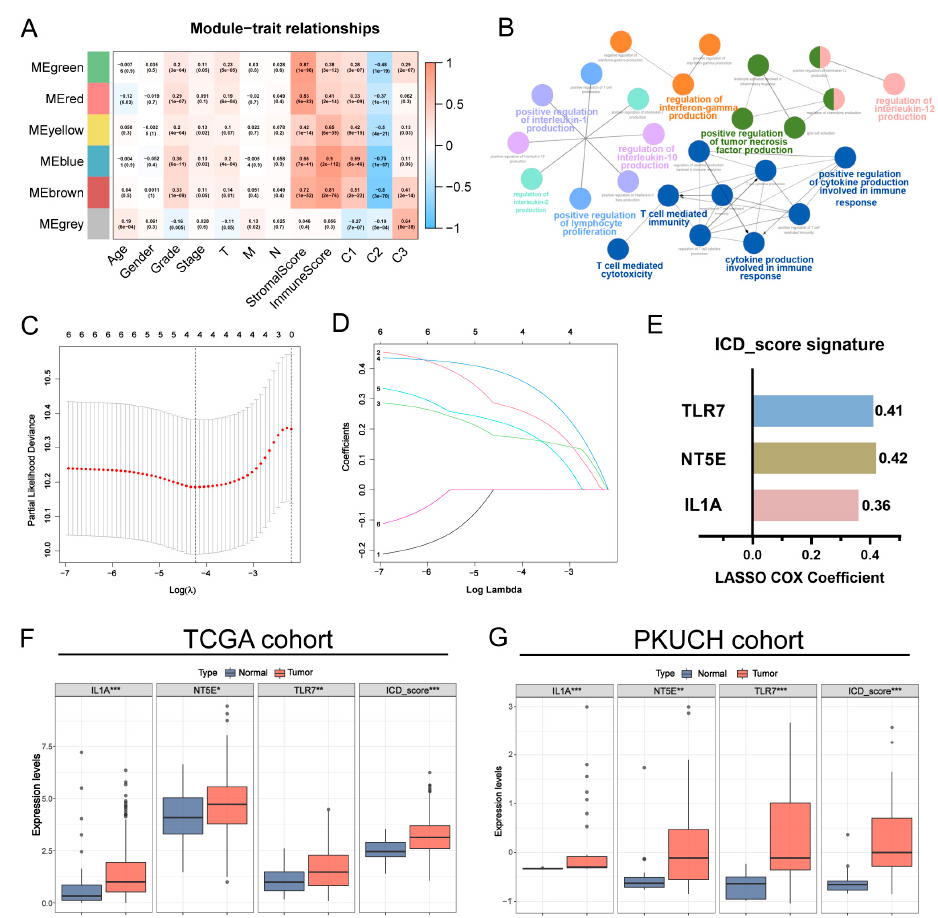
Figure 4. Identification of hub genes by WGCNA and construction of the prognostic ICD_score. ( A ) Heatmap of the correlation between module eigengenes and clinical traits of GC. Each cell includes Pearson correlation coefficient and p value, respectively. ( B ) Functions and pathways of the hub genes were computed and visualized using clueGO. ( C , D ) 10-time cross validation for tuning parameter selection by LASSO regression. The solid vertical lines are partial likelihood deviance ± standard error (SE). The dotted vertical lines are drawn at the optimal values by minimum criteria and 1-SE criteria. ( E ) The ICD_score signature construction. ( F , G ) Expression levels of 3 selected genes and calculated ICD_score between tumors and peritumor tissues in TCGA cohort and our PKUCH cohort, respectively. p values were shown as: * p < 0.05; ** p < 0.01; *** p < 0.001. WGCNA, weighted gene co-expression network analysis; TOM, topological overlap matrix; GS, gene significance; MM, module membership; LASSO, least absolute shrinkage and selection operator